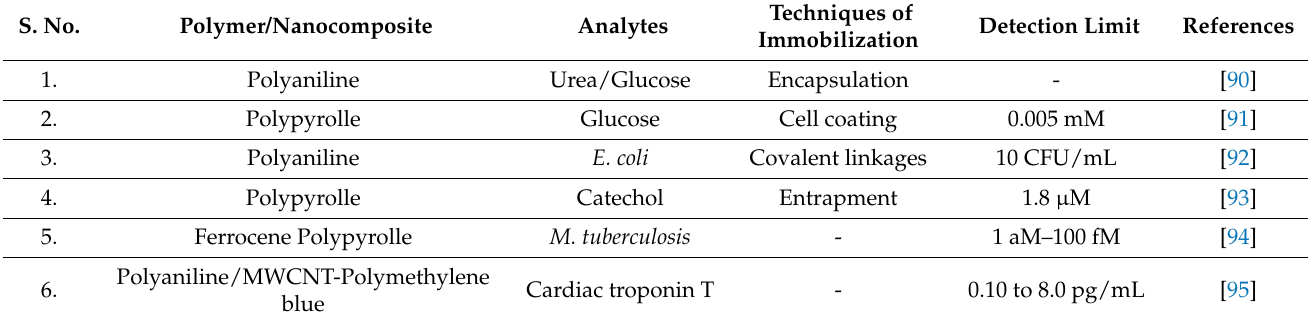
Table 1. Table summarizing various polymers/polymer nanocomposites, analytes, immobilization techniques, and